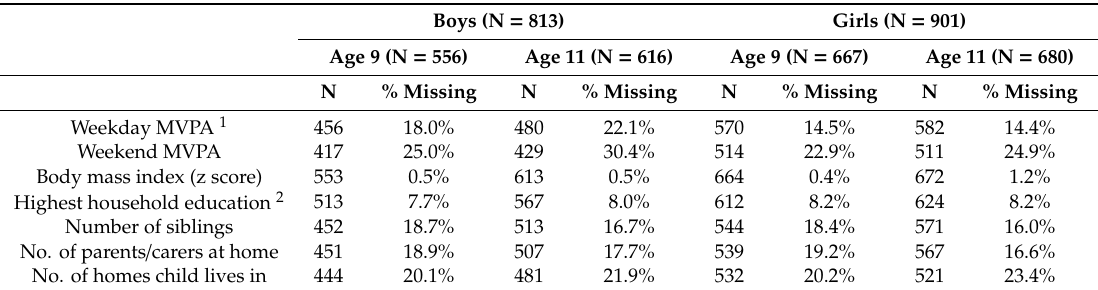
Table 1. Sample sizes and proportion of missing